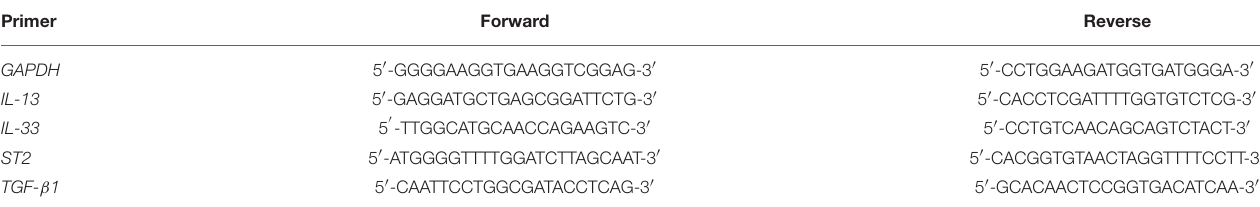
TABLE 1 | Primer genes used in running quantitative reverse transcription polychain reaction (qRT-PCR) along with their forward and reverse sequences. Primer Forward